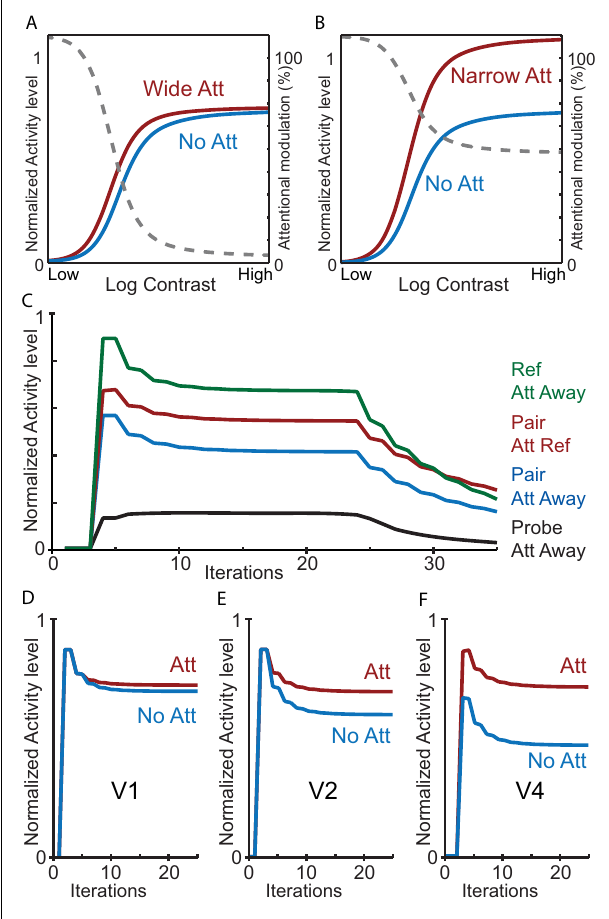
FIGURE 7 | Simulations with the HNO model reproduce a broad range of attention effects. (A,B) Contrast dependency of a neuron responsive